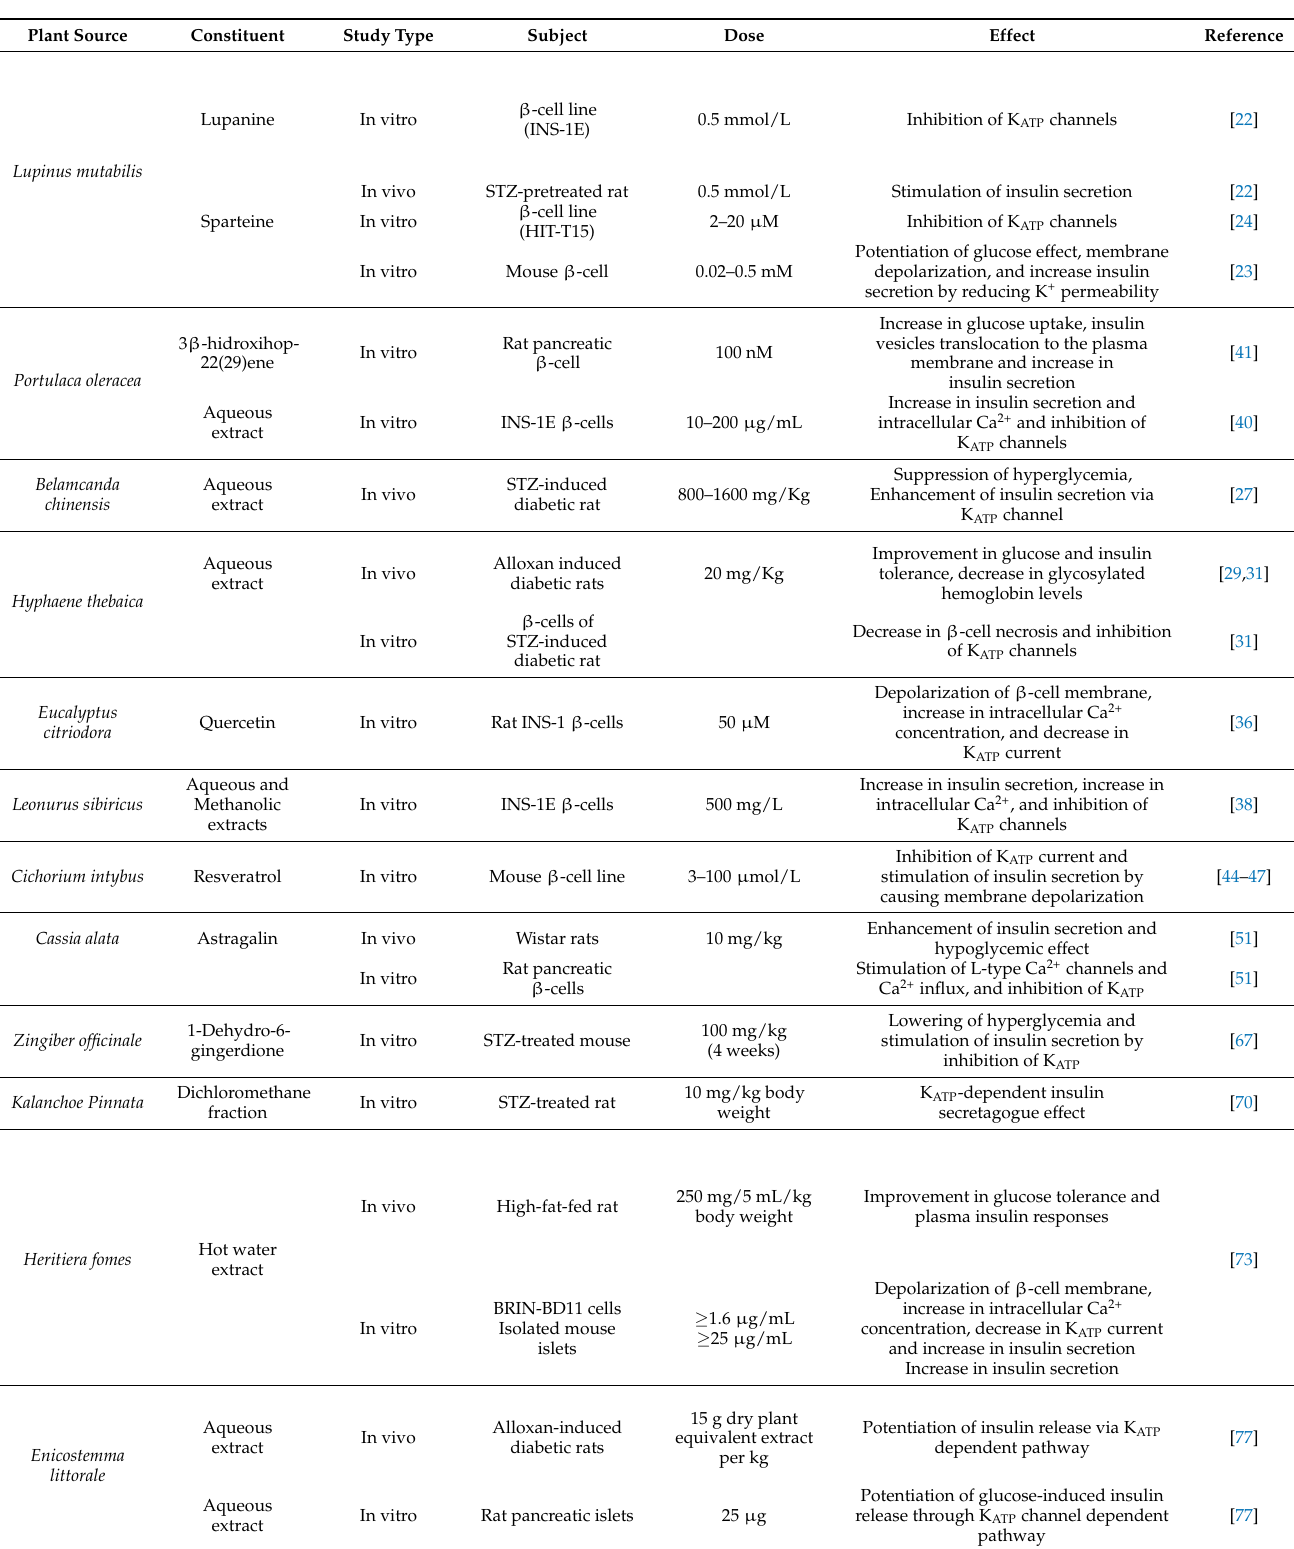
Table 1. Effect of antidiabetic medicinal plants and their active constituents on insulin secretion through the inhibition of pancreatic K ATP